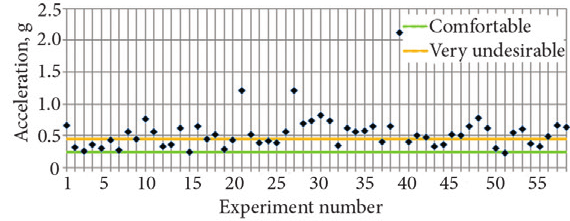
Figure 5. Effect of the analysed trapezoidal speed humps according to the vertical acceleration values by Piersol and Paez (2009)